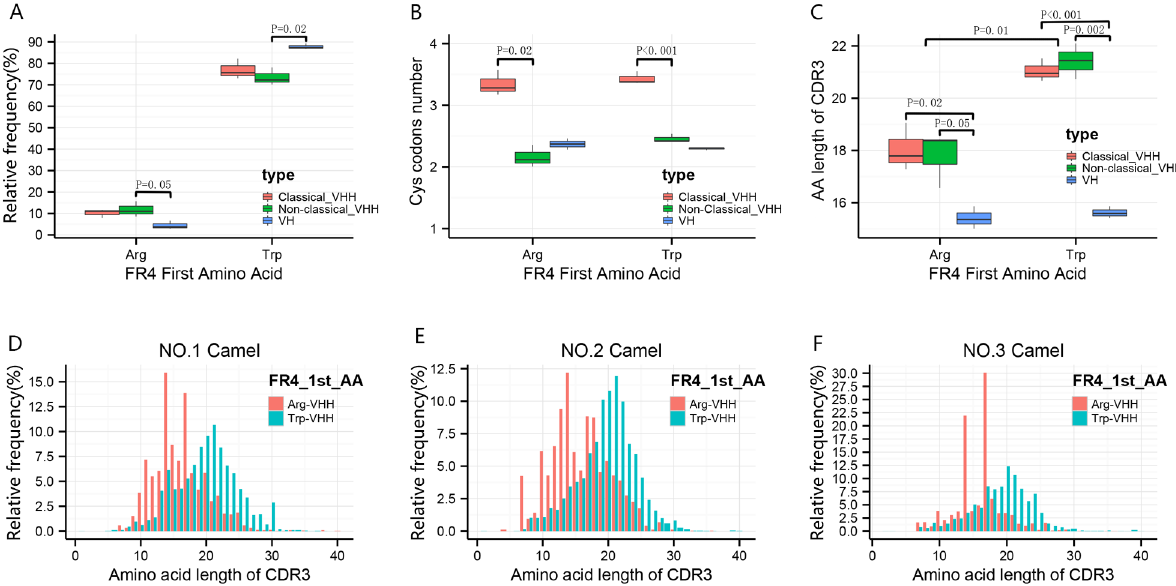
Fig 6. Box plots of the analysis of non-classical VHH clones. a The percentage of Trp-clones and Arg-clones (the clones whose first AA of FR4 are Trp and Arg) for classical VHH, non-classical VHH and VH(3) family clones. b Statistics of Cys codons within the Trp- clones and Arg-clones for classical VHH, non-classical VHH, and VH(3) family clones. c The average CDR3 length statistics of Trp- clones and Arg-clones for classical VHH, non-classical VHH and VH(3) family clones. d-f The proportion distribution of CDR3 average length of Trp-clones and Arg-clones. FR4_1st_AA represents the first AA of FR4 sub-region. Classical VHH represents the VHH having four FR2 hallmark amino acids. Non-classical VHH represents the VHH lacking four FR2 hallmark amino acids. VH represents the VH(3) (clan III) family clones. Box plot explanation: upper horizontal line of box, 75th percentile; lower horizontal line of box, 25th percentile; horizontal bar within box, the median of the three samples ’ data; upper end of the whisker, maximum of the three samples ’ data; lower end of the whisker, minimum of the three samples ’